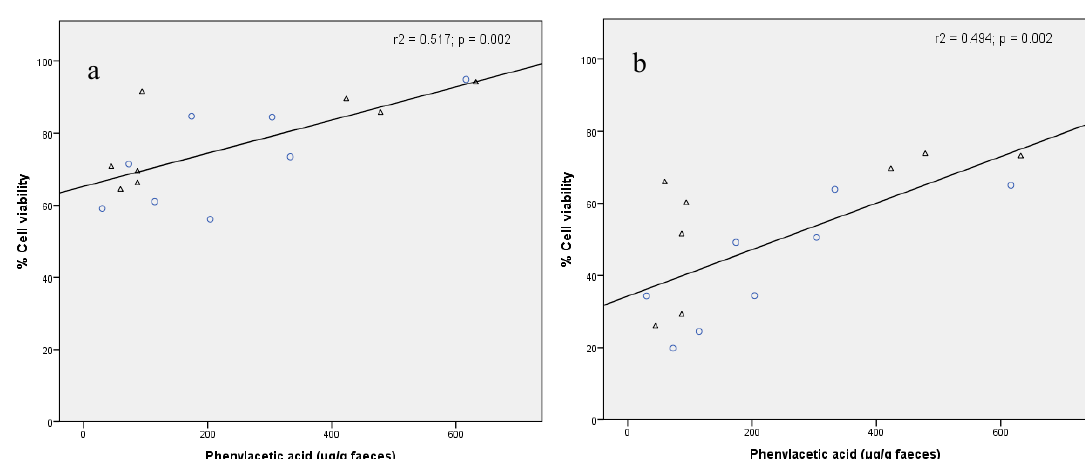
Figure 4. Correlation plots between FW cytotoxicity (percentage viability of HCT 116 cells) and concentration of isobutyric acid (µmol/g faeces), isovaleric acids (µmol/g faeces) and phenylacetic acid (µg/g faeces) in faecal samples collected from volunteers before (O O) and after ( ) the red wine intervention. Cytotoxicity assay conditions: 1:5 ( v/v ) for FW dilution, and 4 ( a ) and 24 h ( b ) for incubation time.